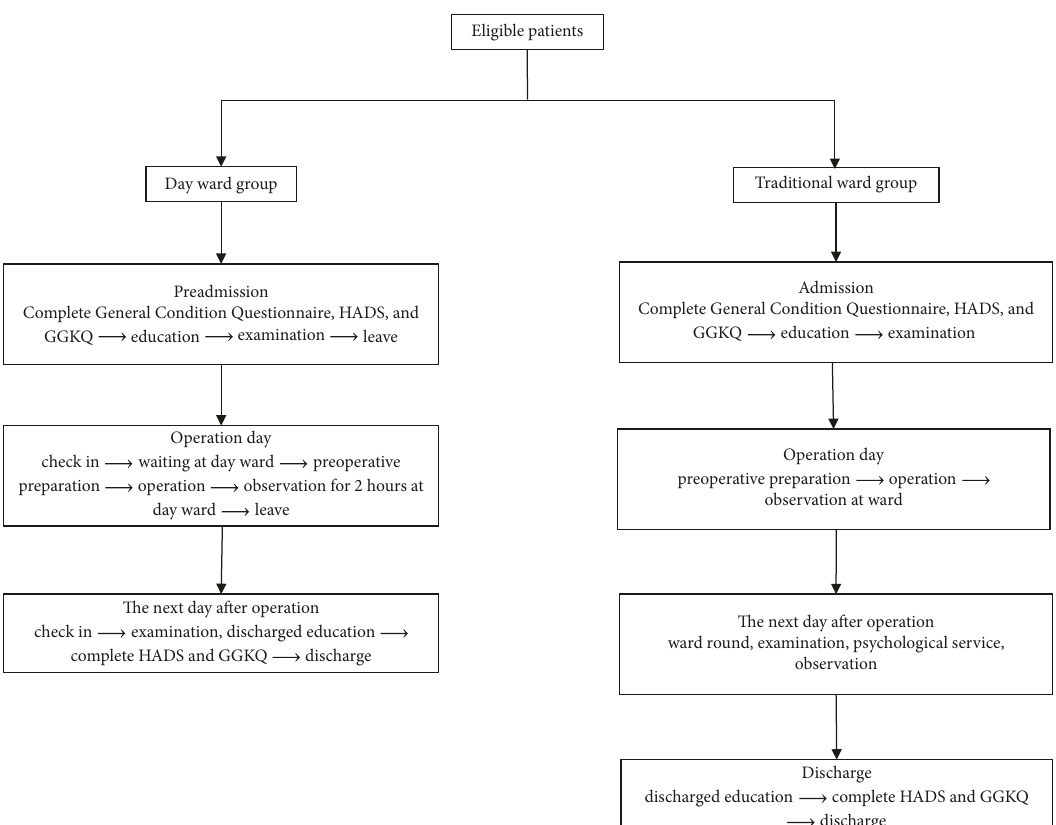
Figure 1: Flow diagram of procedures the patients went through. HADS, Hospital Anxiety and Depression Scale; GGKQ, Gray Glaucoma Knowledge